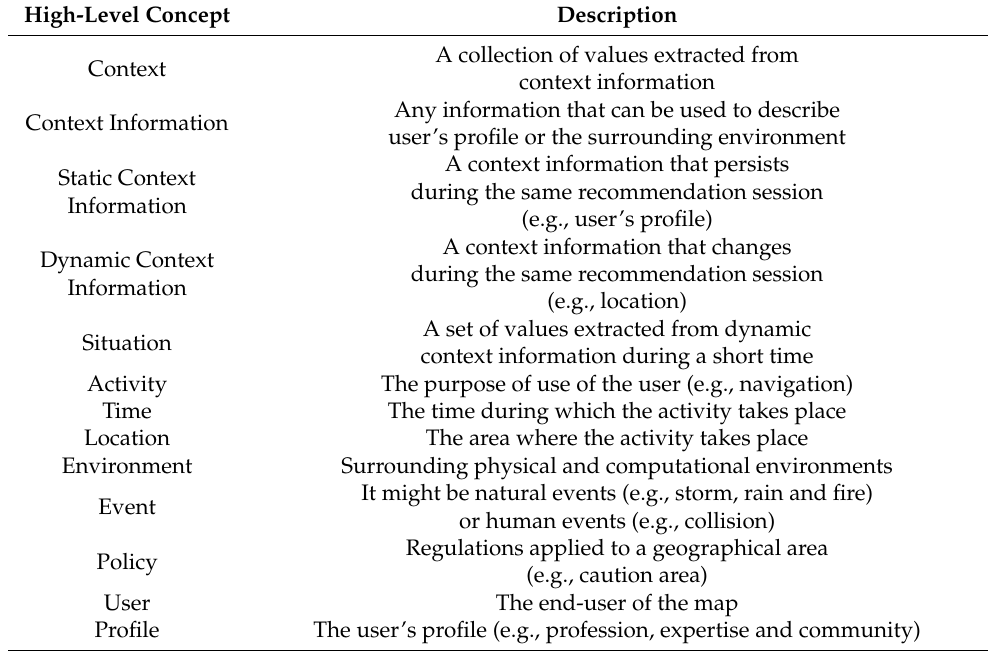
Table 2. High-level concepts for context